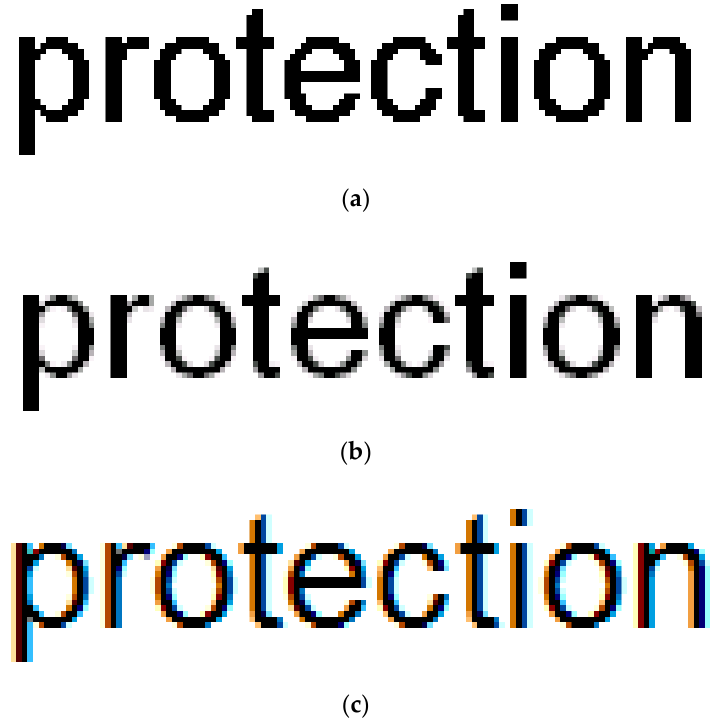
Figure 4. Application effects of edge smoothing modes of graphic characters in Windows XP OS: ( a ) without edge smoothing mode (inaccessible for Windows 7 OS), ( b ) Standard edge smoothing mode, and ( c ) ClearType edge smoothing mode.